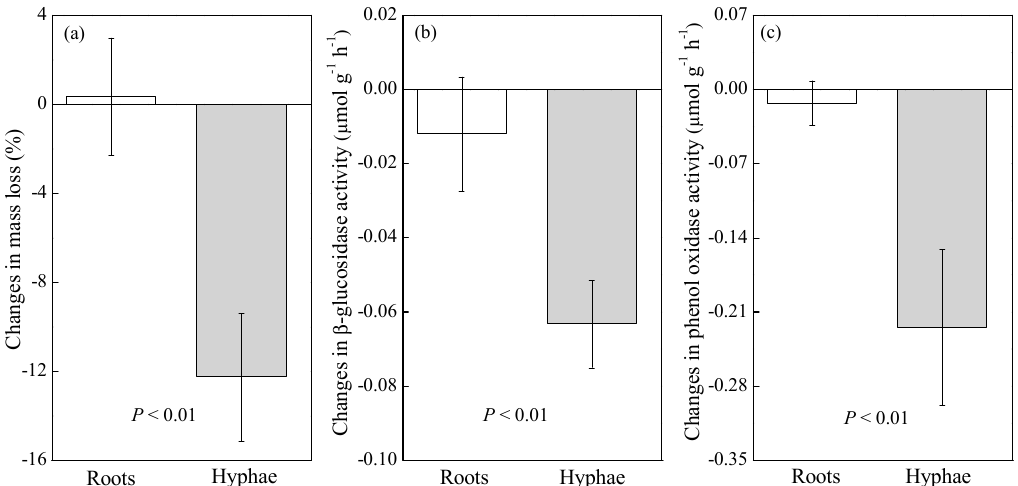
Figure 3. Changes in root litter mass loss ( a ), and activities of β -glucosidase ( b ) and phenol oxidase ( c ) induced by the presence of living roots (Roots) and mycorrhizal hyphae (Hyphae). p -values were obtained from linear mixed models analyzed across all the studied tree species, which were performed to test whether living roots significantly differed from mycorrhizal fungi in their effects on mass loss and enzyme activities. Error bars represent 95% confidence intervals (CIs). When 95% CIs do not overlap with y = 0, the presence of living roots or mycorrhizal fungi significantly affects root litter mass loss and enzyme activities.